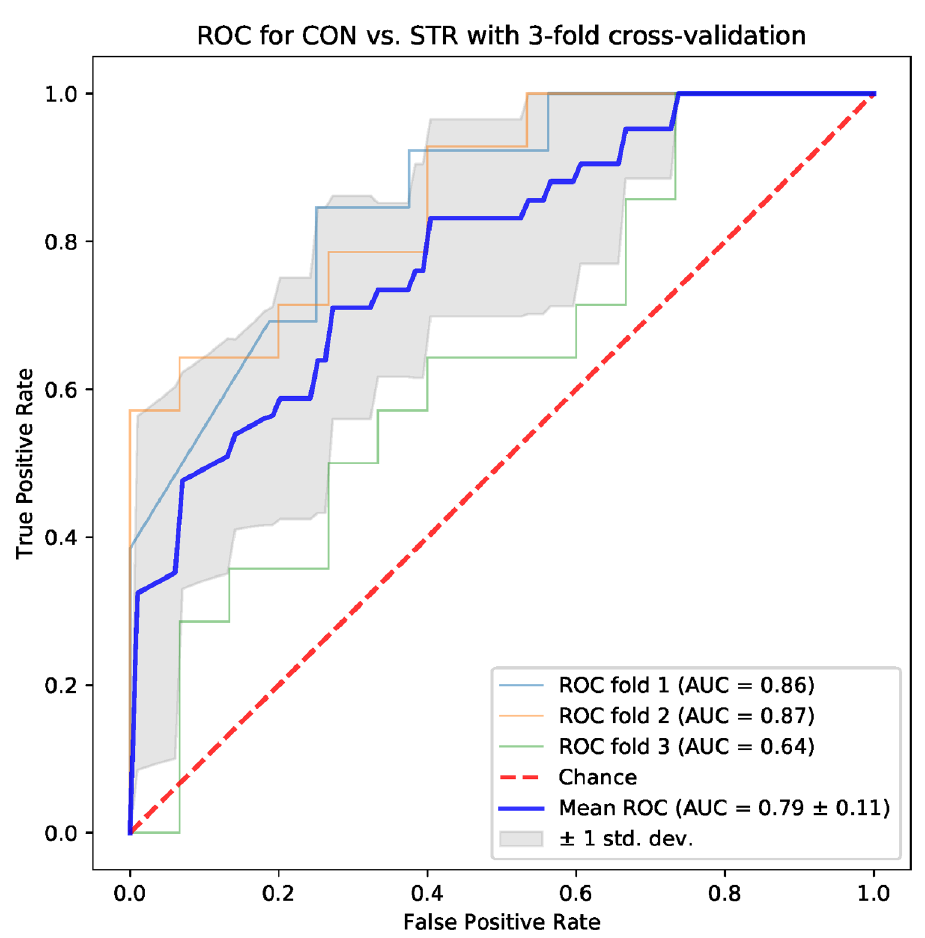
Fig 5. Results for the model trained with four classical hrv time domain parameters: Mean nni , sdnn , pnni 50 , rmssd